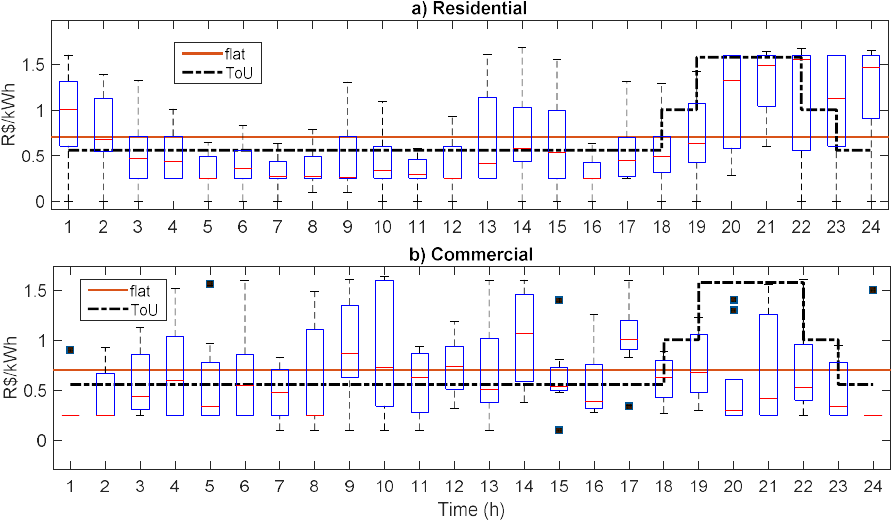
Figure 13. Boxplot of an intelligent dynamic tariff with PV generation. ( a ) Residential. ( b ) Commercial.